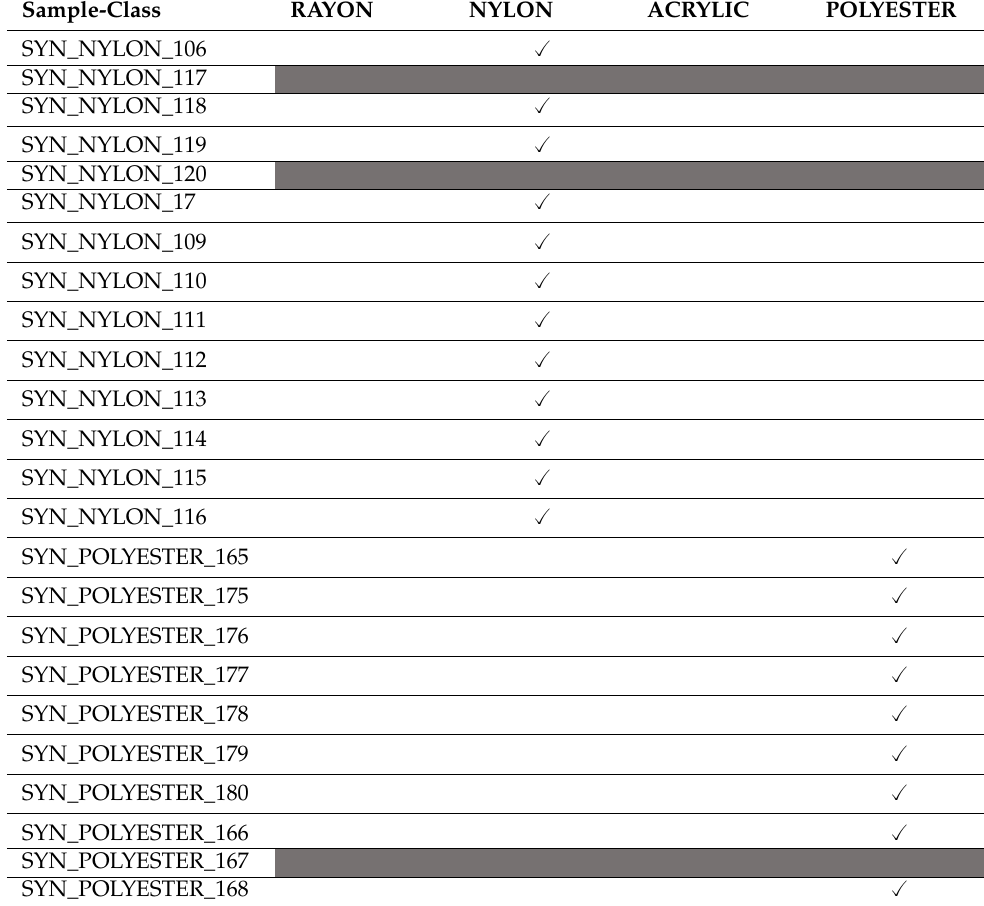
Table 1. SIMCA classification